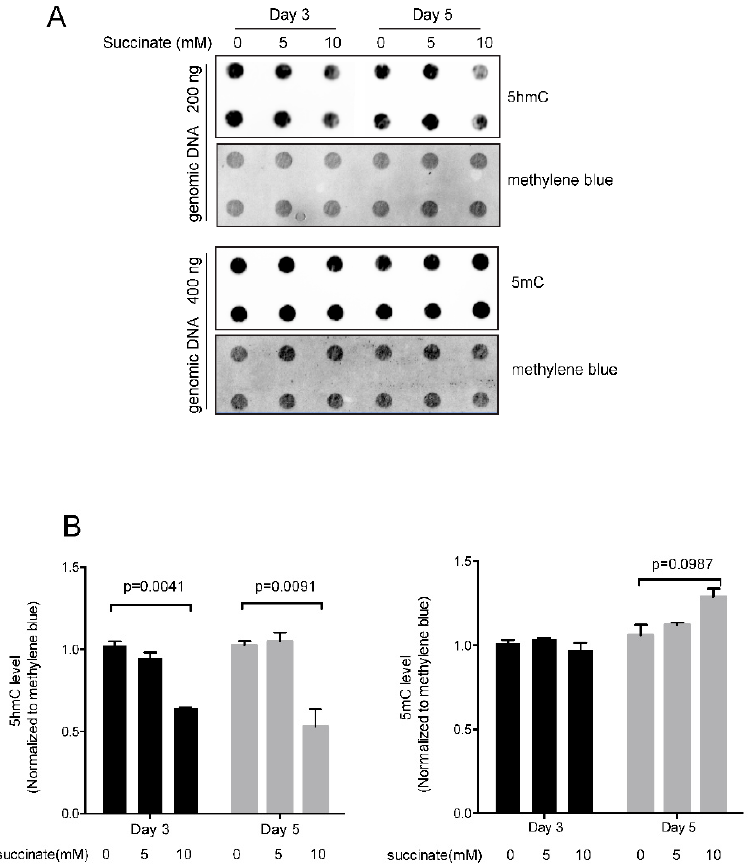
Figure 1. Quantitation of 5-hydroxymethylcytosine and 5-methylcytosine in succinate-treated cells. ( A ) Immuno-dot blot of 5hmC and 5mC. Bronchial epithelial cells were treated with 5 or 10 mM succinate for three days or five days. DNA was spotted onto a nylon membrane and the modified bases were detected using an anti-5hmC or anti-5mC antibody. Staining of the membrane with the DNA-binding dye methylene blue served as a loading control. ( B ) Quantitation of the 5hmC and 5mC data. A significant reduction in 5hmC levels was observed at a concentration of 10 mM succinate after three or five days. There was no significant change in 5mC levels. Three independent experiments were performed in this